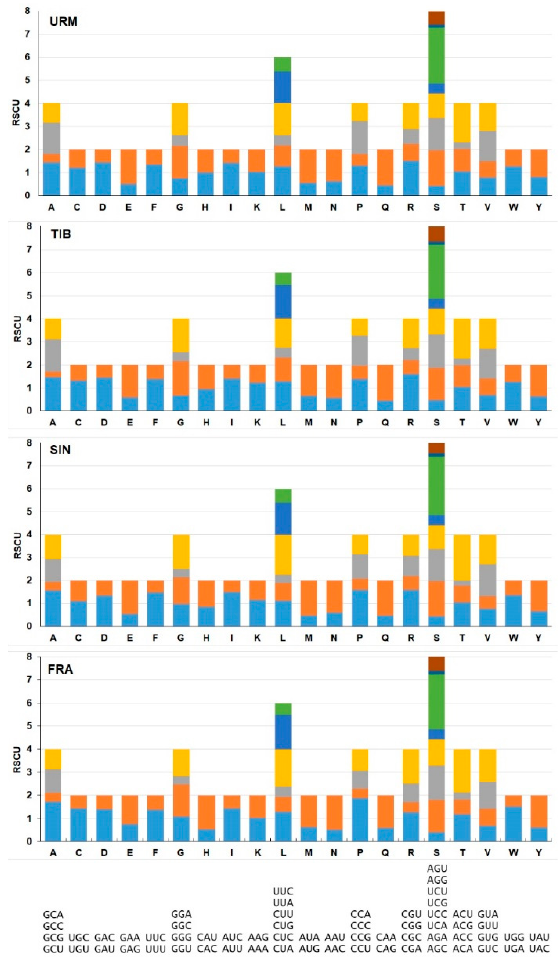
Figure 4. Relative synonymous codon usage (RSCU) in A. urmiana and three related species in genus Artemia . Codon families were mentioned by the one letter and synonymous codons were listed on the x -axis (URM: A. urmiana , TIB: A. tibetiana , SIN: A. sinica , FRA: A. franciscana ).